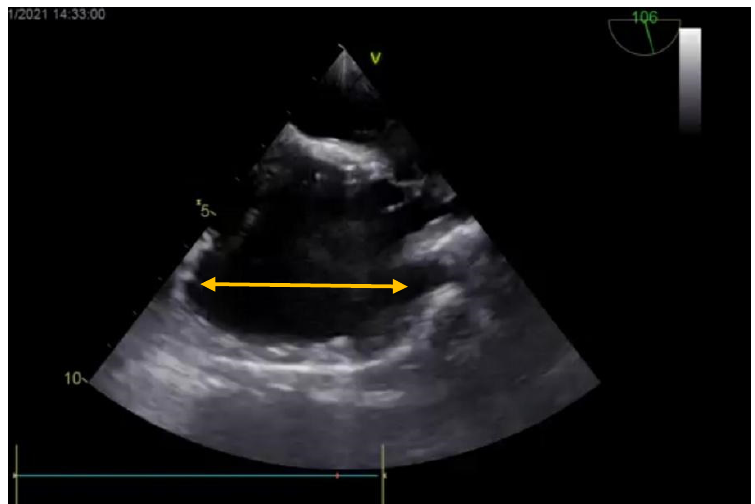
Figure 7. Postoperative echocardiography (bicaval view) showing the closed ASD and the plasty enlarging the SVC and right atrium (yellow arrow).